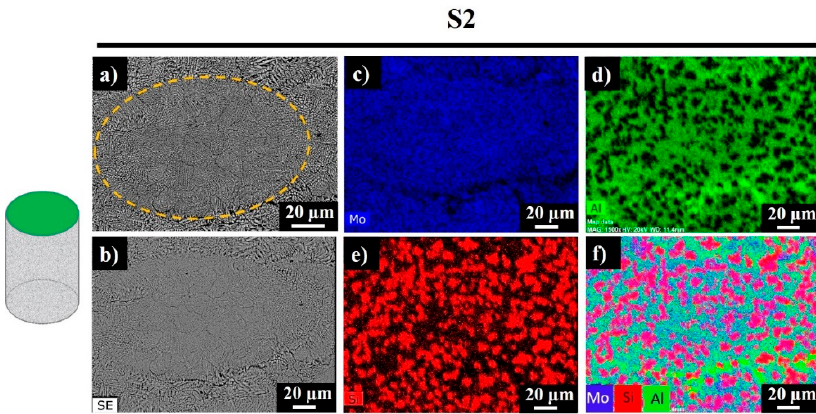
Figure 7. Top surface backscattered electron (BSE) image ( a ), secondary electron (SE) image ( b ), and EDS mapping results ( c – f ) for sample S2.